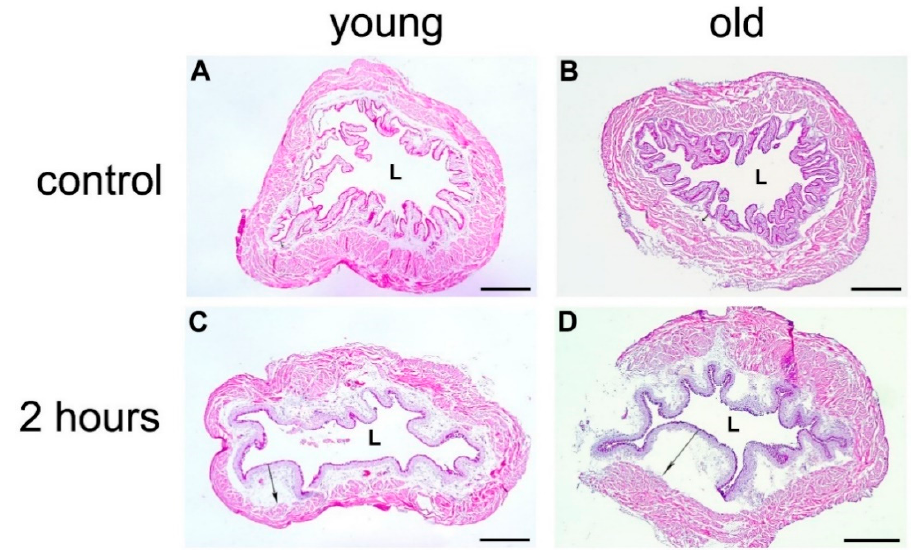
Figure 8. Representative images of urinary bladder cross-sections of the control young and old mice with marked normally thick lamina propria (arrow) ( A , B ) and 2 h after chitosan treatment with marked thickened lamina propria due to edema (arrow) ( C , D ). Hematoxylin and eosin (H&E) staining. L-lumen of the urinary bladder. Scale bars: 0.5 mm (all images).